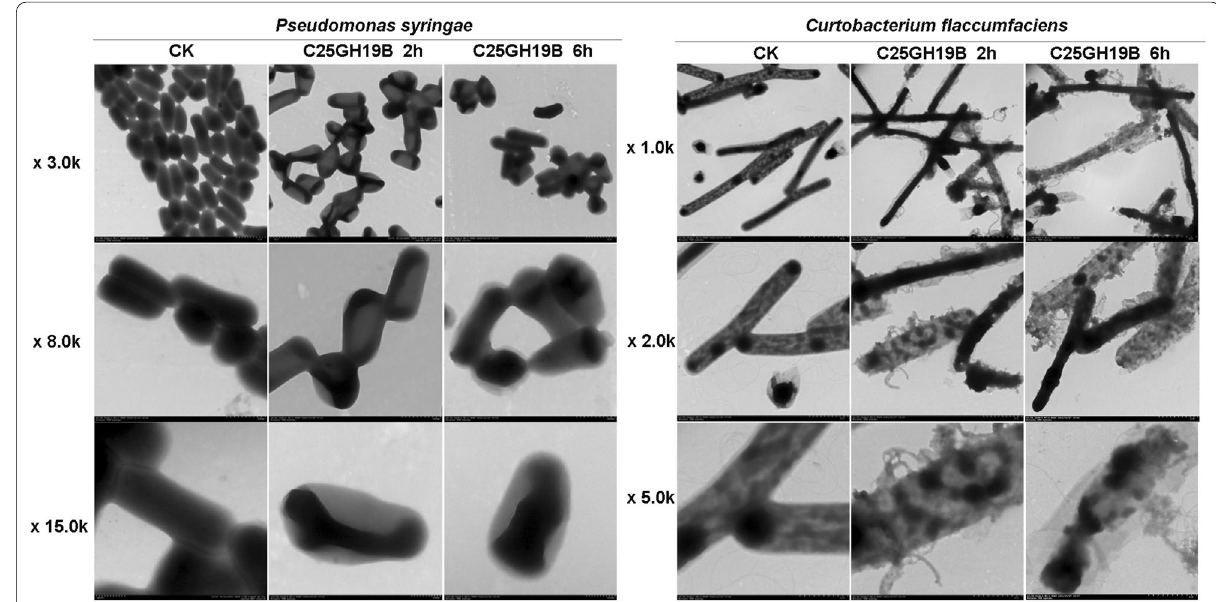
Fig. 6 Transmission electron microscopy of C. flaccumfaciens and P. syringae . The freshly cultured cells were treated with 0.5 mg/mL C25GH19B at 37 °C for 2 h or 6 h. 50 mM sodium acetate buffer was used as the control group